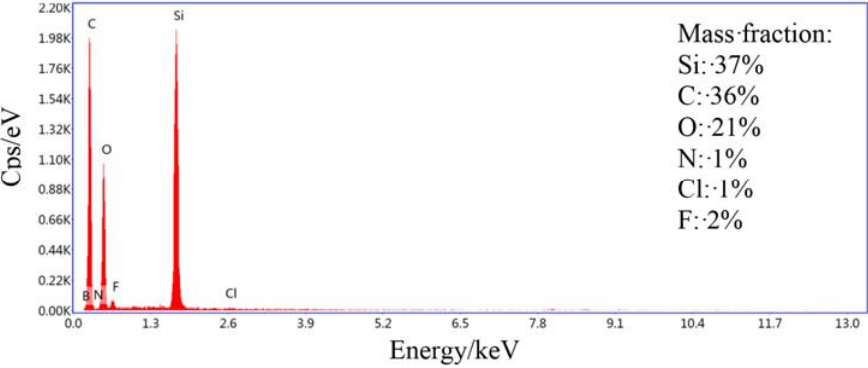
Figure 7. EDX spectra of the resulting materials.